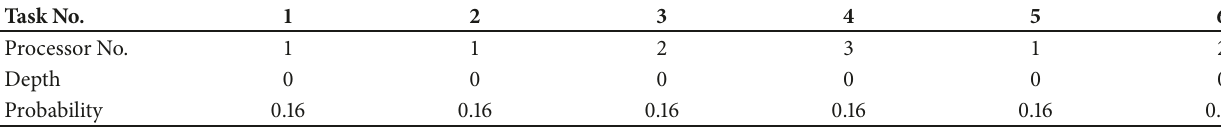
Table 2: Extended chromosome structure for a sample DAG.